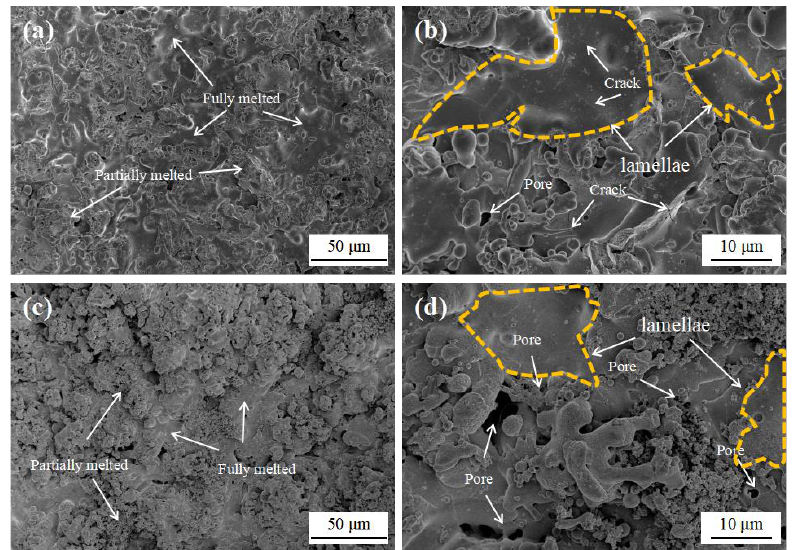
Figure 5. SEM images of ( a , b ) micro Al 2 O 3 coating (CC) and ( c , d ) nano Al 2 O 3 coating (NC). Figure 6a,b depict the surface three-dimensional morphology of the CC and NC, re- spectively. The root-mean-square heights (Rq) of the surfaces of the CC and NC are 9.984 μm and 18.347 μm. According to the literature, the surface roughness of a coating is in- versely proportional to the melting degree of the powder [37]. As a result, the nanostruc- tured coating exhibits a higher degree of surface roughness due to the lower melting de- gree of the nanopowder. Figure 6. Surface morphology of ( a ) micro Al 2 O 3 coating; ( b ) nano Al 2 O 3 coating. The cross-sectional morphologies of the coatings are shown in Figure 7. The inter- faces among the substrate, the NiCrCoAlY bonding layer, and the ceramic coating can be observed. The thickness of the bonding layer in both coatings is 70- 120 μm, the thickness of the ceramic coating of the CC ranges from 287-342 μm (Figure 7a), and the thickness of the ceramic coating of the NC ranges from 285-317 μm (Figure 7c). The porosity of the coating was measured by MicroEYE 3000 software. The average porosity observed in the CC was 3.48% compared to 5.21% for the NC.